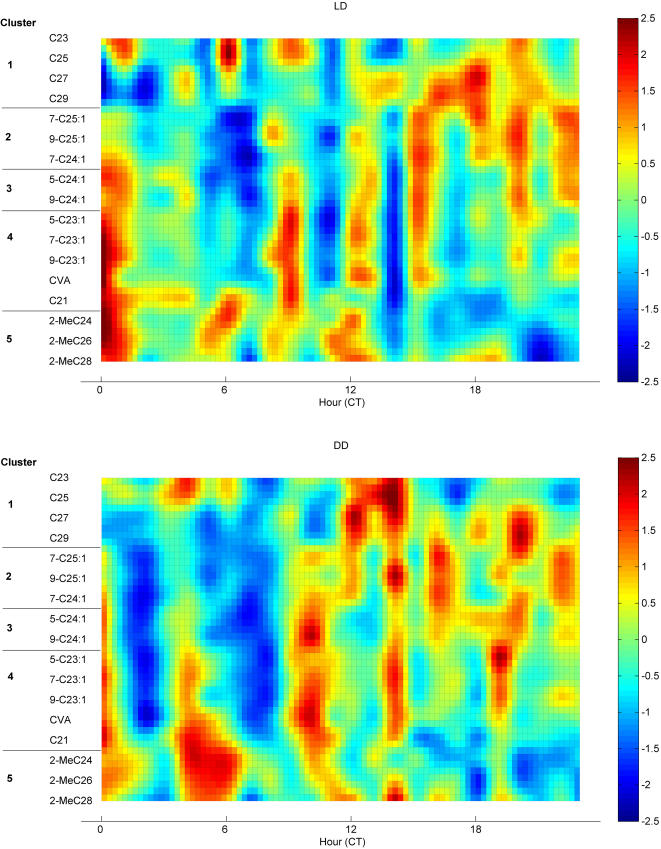
Diurnal changes in compounds.(A) LD (B) DD. Heat map shows compound hourly mean scaled to daily mean of 0 and SD of 1. Units of color map are SD. Note LD minimum at CT 14 becomes a peak for most compounds in DD; similar effects occur around CT 10 in clusters 2–4.